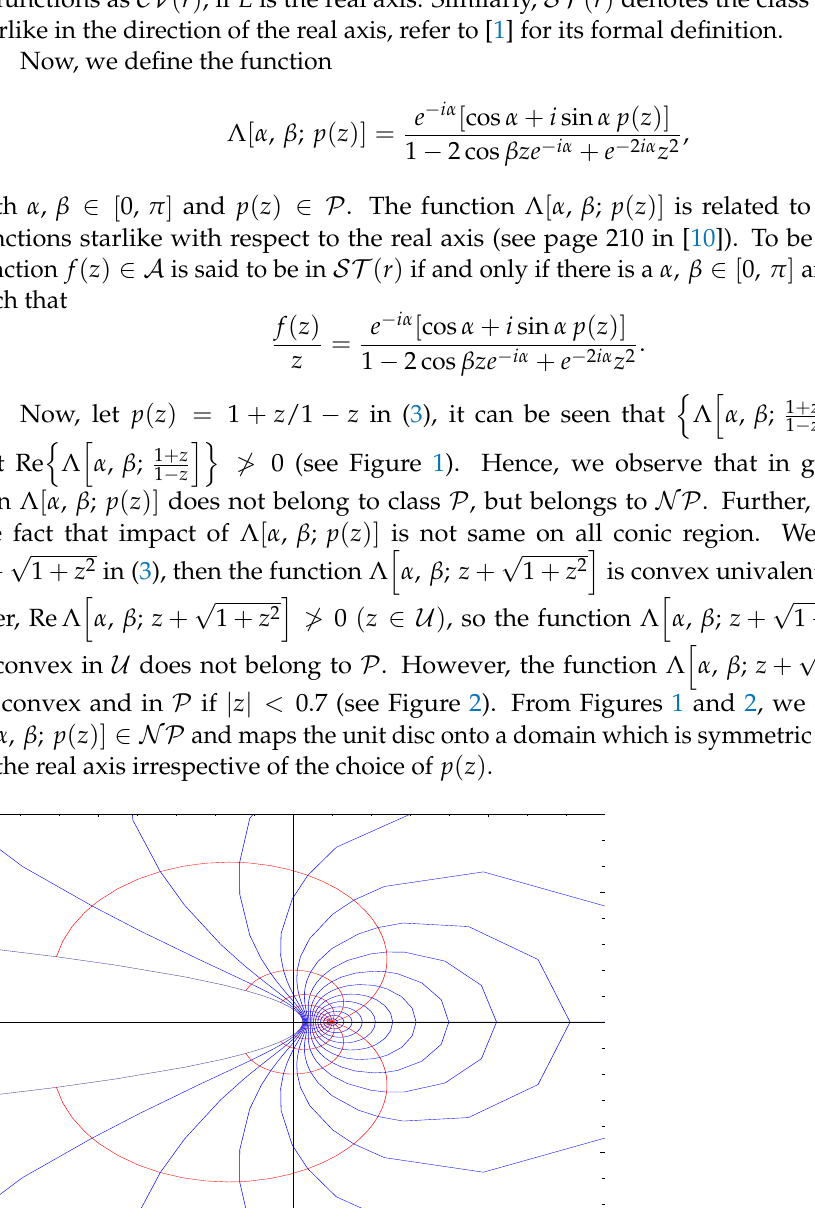
Figure 1. Mapping of the unit disc under Λ